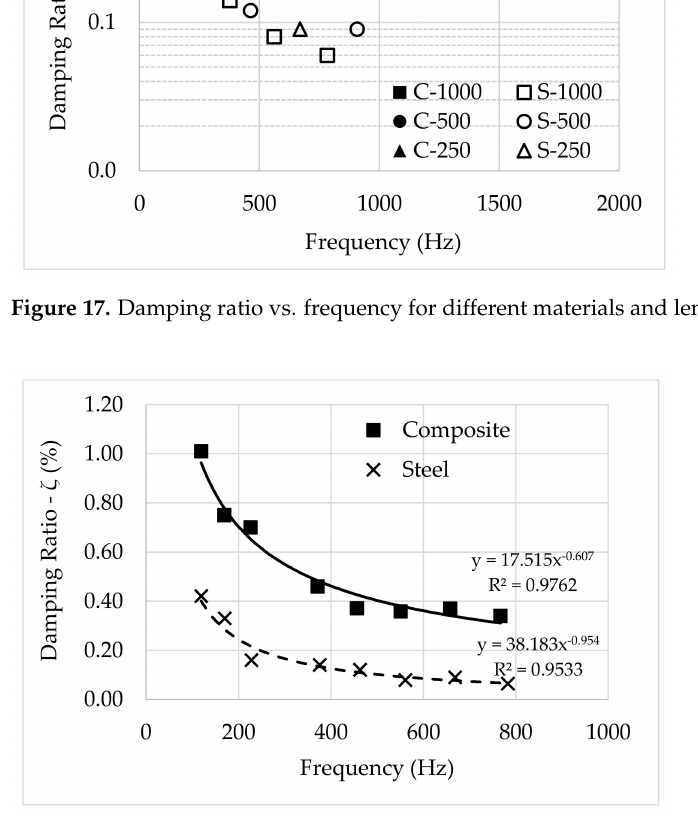
Figure 18. Damping ratio vs. frequency: Curve fitting.